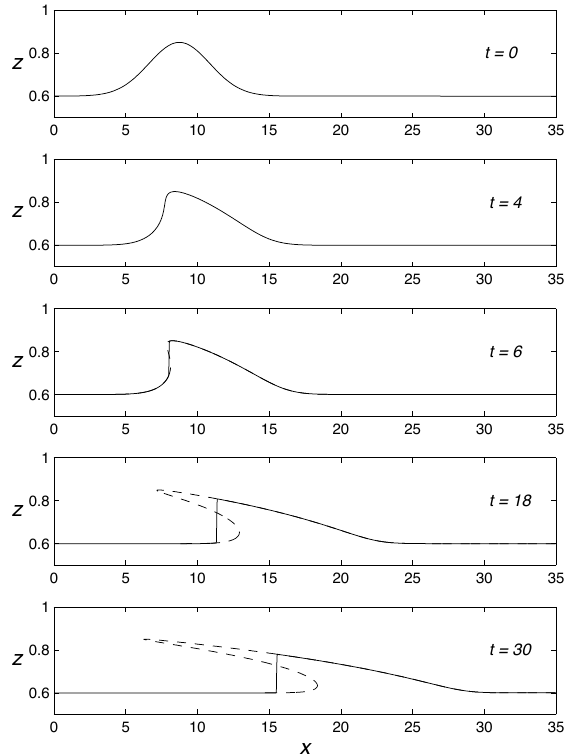
Fig. 3. Layer interfaces from the three-layer numerical solution for D 1 = 0 . 54, D 2 = 0 . 12, and D 3 = 0 . 34, and 1 3 / 2 = 1 5 / 2 = 0 . 5. The initial condition is given by Eqs. (28) and (29) with a 0 = 0 . 25 and b = 1 /